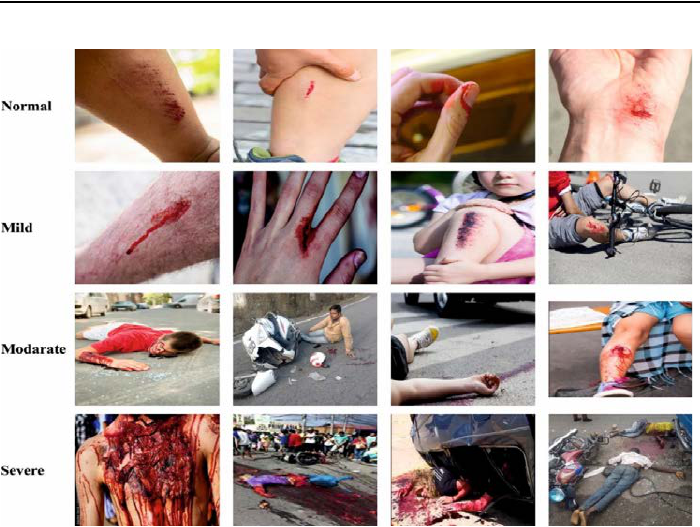
Figure 2. Sample Images of Multiclass.